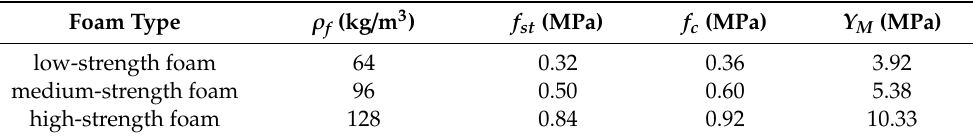
Table 3. Bed lining material properties used in hydro-abrasion